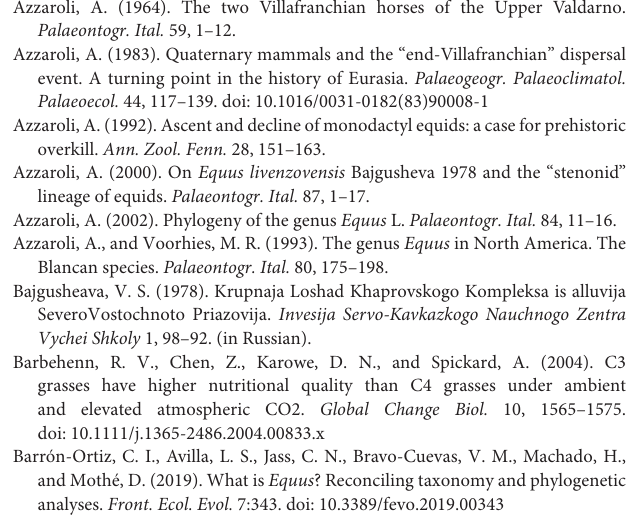
Supplementary Figure 1 | Ninety-five percent probability ellipse for bivariate normal distribution of the Pleistocene Equus body mass and mesowear score ( Saarinen et al., 2016) data. Supplementary Table 1 | Skeletal and dental measurements of extant zebras used in this study, and corresponding body mass estimates. Measurement codes of Janis (1990), Scott (1990), and Alberdi et al. (1995) are provided, with description of each measurement. Body mass estimates are provided for each measurement based on the equation indicated in the “Measurement codes” -column. Supplementary Table 2 | Body mass estimates and mesowear of Pleistocene European Equus paleopopulations. The table “Species-Age” provides mean body mass estimates and mesowear of the Equus paleopopulations with the information of localities and their stratigraphic ages. The table “Specimen” lists body mass estimates for each Equus specimen based on metapodial measurements (Scott,